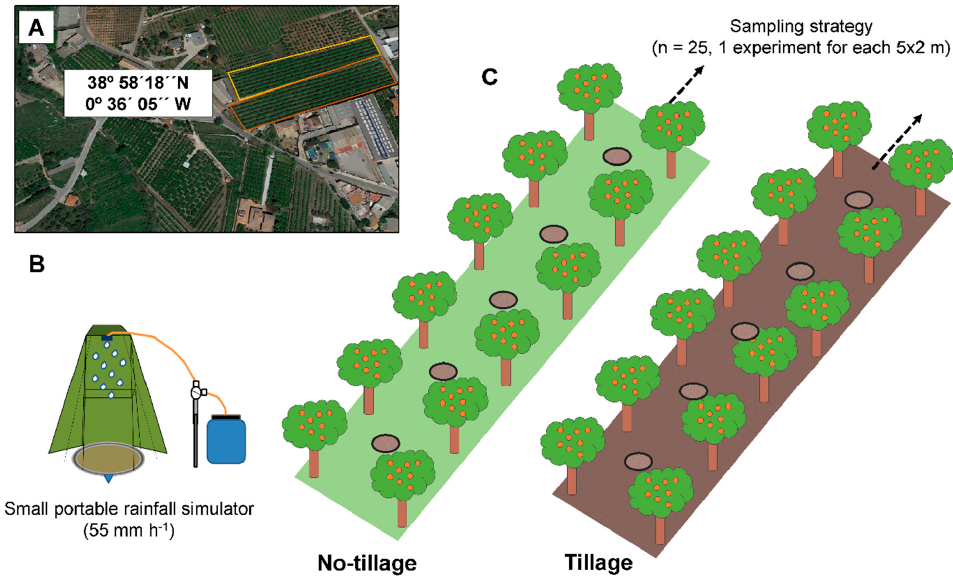
Figure 2. View of the “La Canyadeta” experimental design and plots. ( A ): location map; ( B ): rainfall simulator layout; and, ( C ): experimental design with two rows of persimmon, one under Tillage and one under No-Tillage with weeds. Each one had 25 plots, located in between the persimmon trees, here represented by the circle of the rainfall simulator plot.